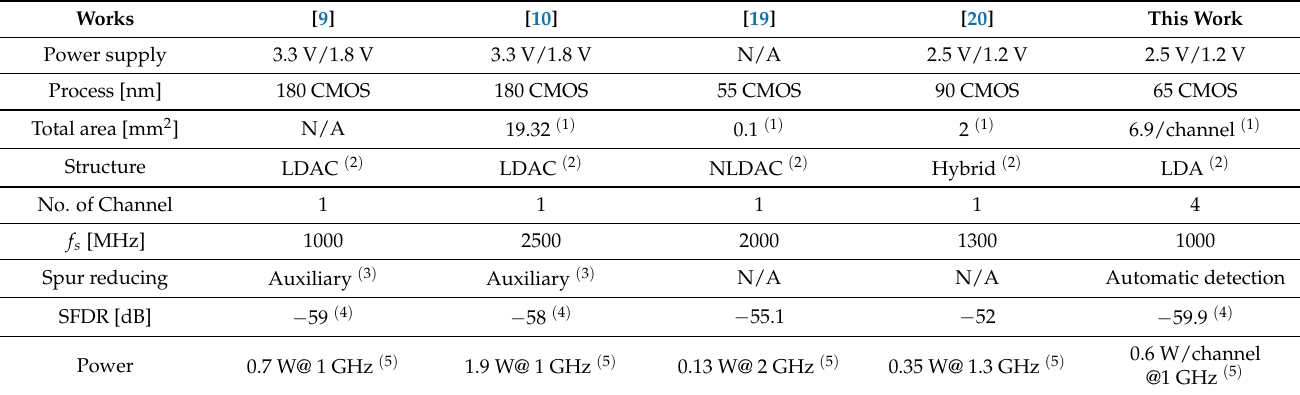
Table 1. Comparing the spurs characteristics with other DDSs.